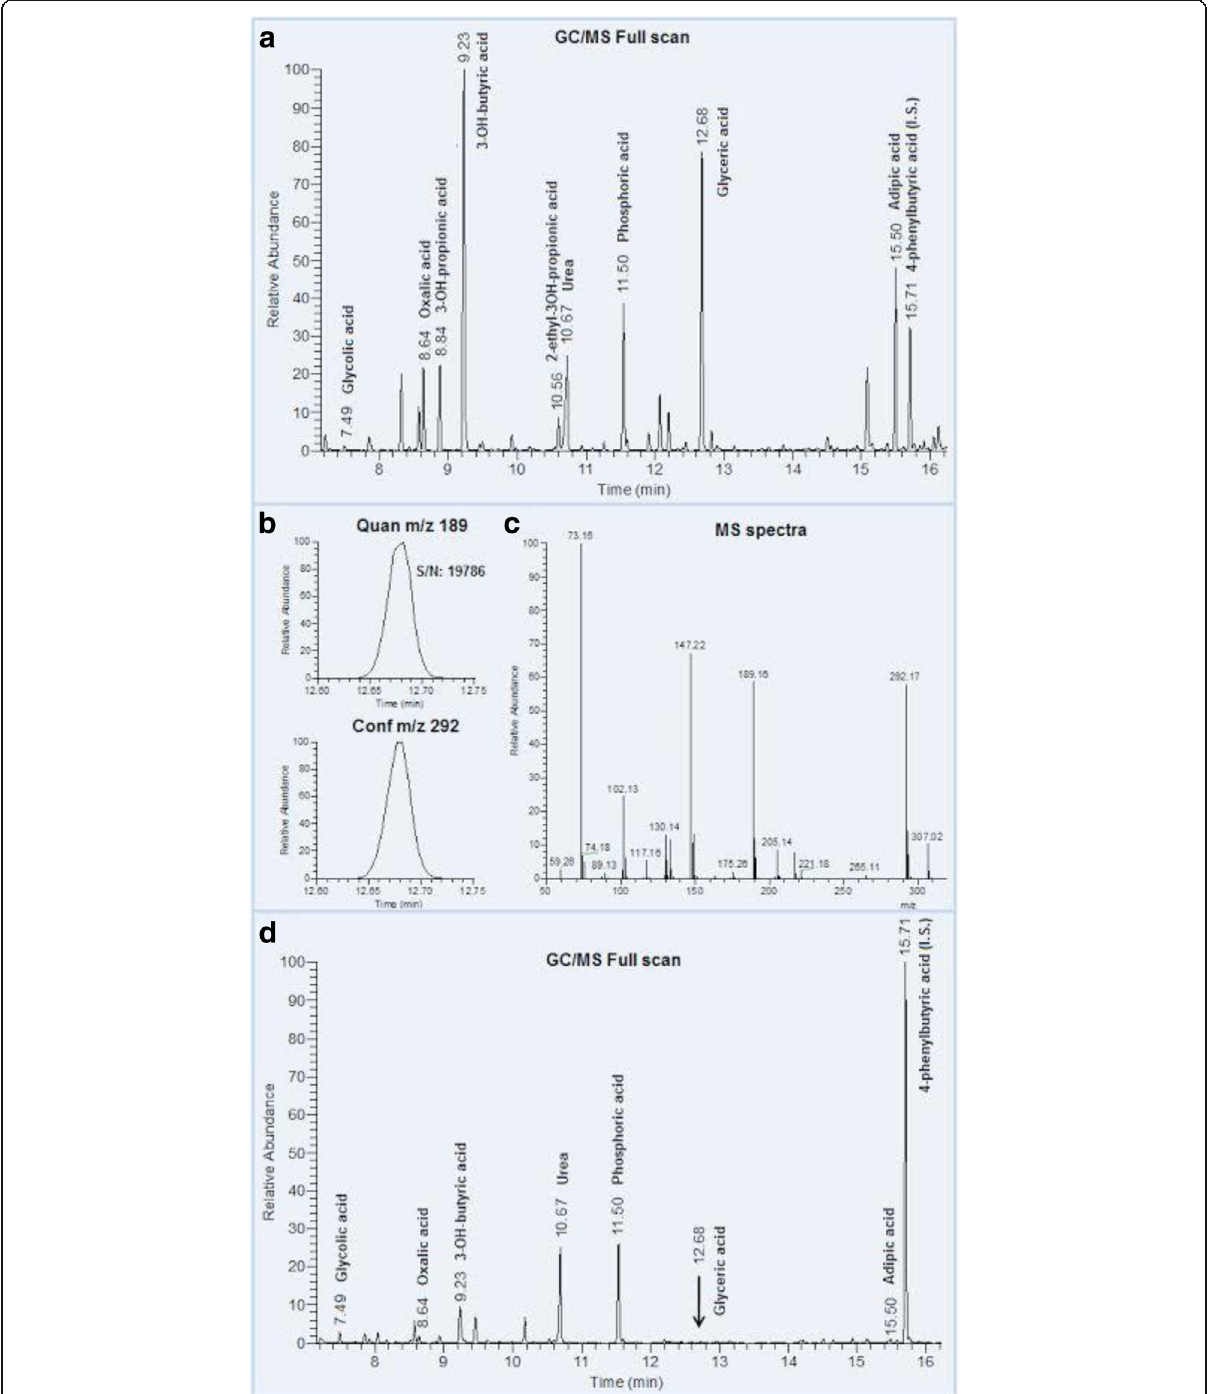
Fig. 2 GC/MS chromatogram of urine organic acids of patient with PH2 and control sample. a The total ion current chromatogram of urine organic acids of patient sample with markedly elevated peak in retention time 12.68 corresponding to glyceric acid (MU-1342). b The presence of two characteristic ions for glyceric acid with high signal to noise ratio (S/N) for quantitative ion in patient ’ s sample. c MS spectra of peak corresponding to glyceric acid. d The total ion current chromatograph of urine organic acids of control sample with negligible peak of glyceric